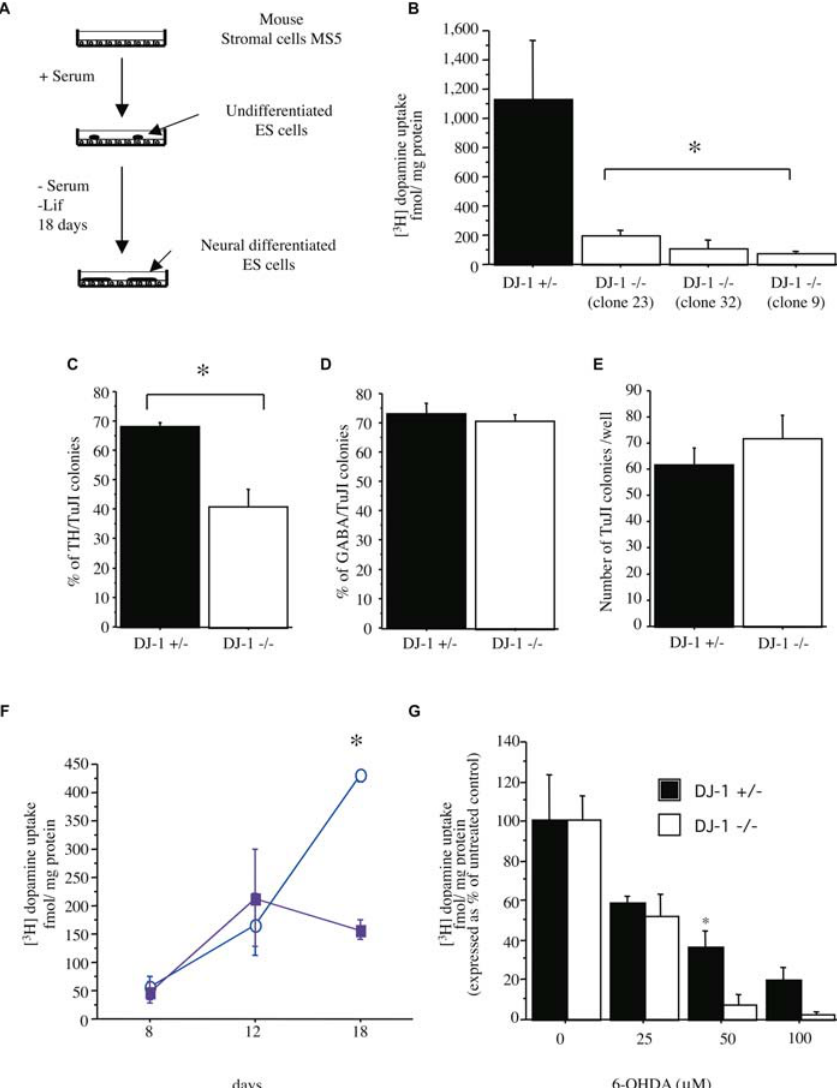
Figure 3. DJ-1-Deficient ES Cell Cultures Display Reduced DN Production (A) The SDIA coculture method. DJ-1 knockout or control heterozygous ES cells are cocultured with mouse stromal cells (MS5) in the absence of serum and leukemia inhibitory factor for 18 DIV. (B) DN production was quantified at 18 DIV by 3 H-dopamine uptake assay. DJ-1- deficient ES cell cultures were defective relative to heterozygous control cultures. (C–D) Neuron production was quantified by immunohistochemical analysis as a percent of TuJ1-positive colonies that express TH (C) or GABA (D). Quantifi- cation of TH and GABA immunostaining was performed on all colonies in each of three independent wells. Colonies were scored as positive if any immunostained cells were present. * p (cid:1) 0.05. (E) The absolute number of TuJ1-pos- itive colonies was not significantly differ- ent between the two genotypes. (F) Kinetic analysis of DN differentiation in DJ-1-deficient cultures (clone 32, solid square) and heterozygous controls (open circle) as quantified by 3 H-dopamine uptake assay. * p (cid:1) 0.05. (G) DJ-1-deficient (open bar) and heter- ozygous control (closed bar) cultures differentiated for 9 DIV and then ex- posed to 6-OHDA at the indicated dose for 72 h. DNs were quantified by 3 H- dopamine uptake assay. Data represent the means 6 SEM and were analyzed by ANOVA followed by Fisher’s post-hoc